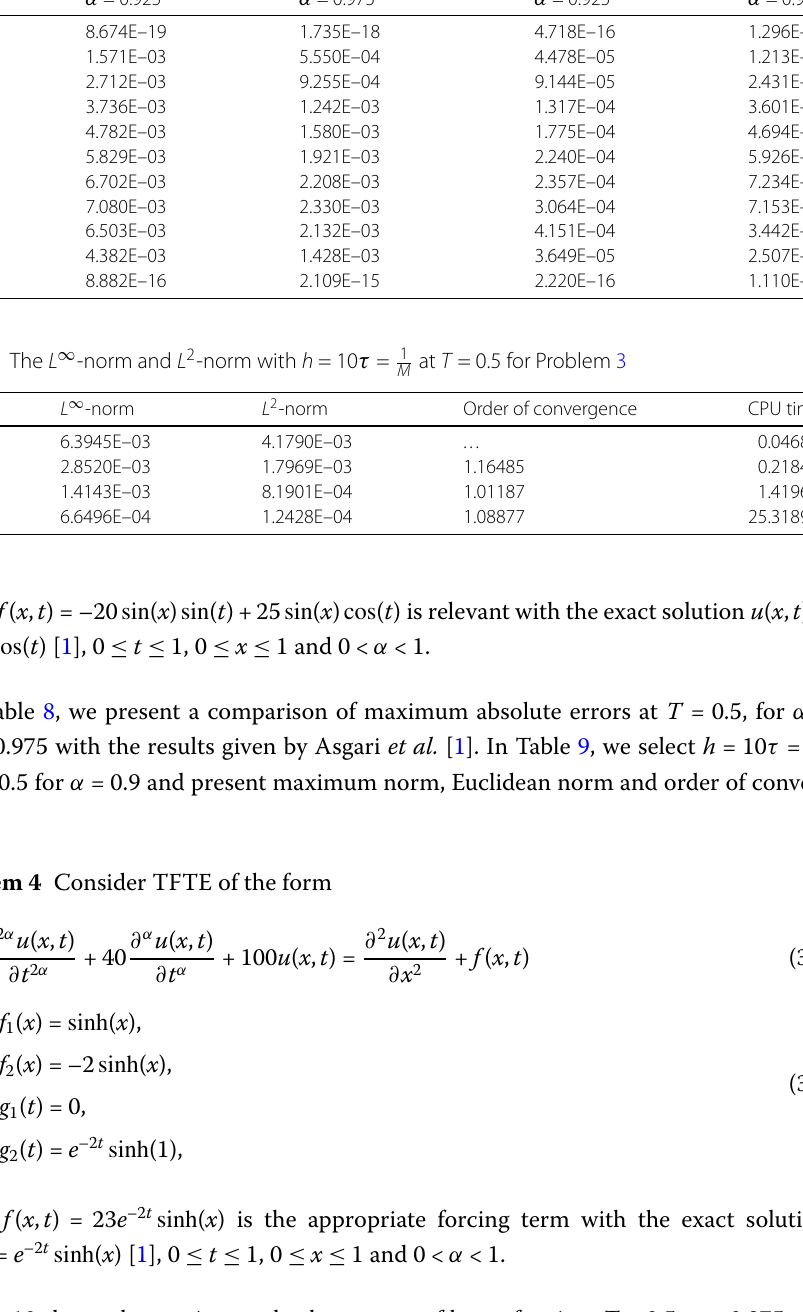
Table 8 A comparison of maximum absolute errors at T = 0.5 for Problem 3 x Collocation method [1] Proposed method α = 0.925 α = 0.975 α = 0.925 α = 0.975 0.0